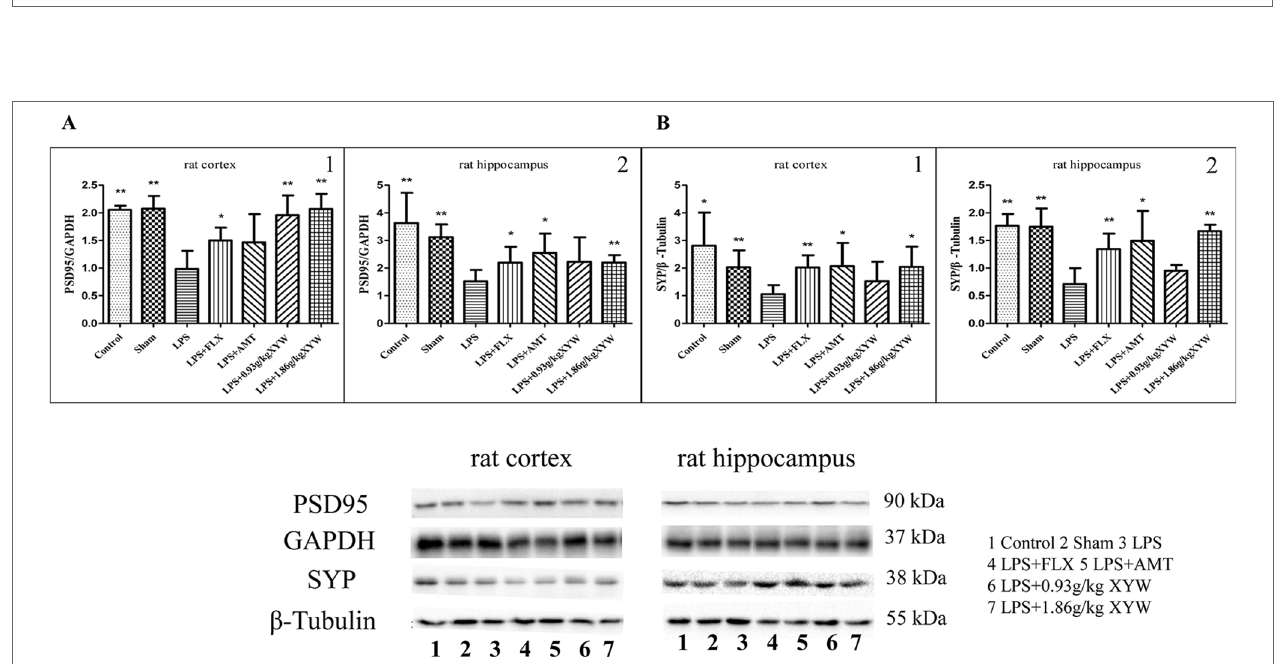
FIgURe 5 | LPS administration acutely reduced the expression of brain-derived neurotrophic factor (BDNF)/neuronal growth factor (NGF)-Tropomyosin receptor kinase (Trk) B/TrkA- cAMP response element-binding protein (CREB) in different brain regions. (a, F) Rats, The expression levels of BDNF/NGF-TrkB/TrkA-CREB following LPS treatment were significantly lower than those in the control and sham groups (P 0.05 or P 0.01), with 2 weeks of prior XYW administration (LPS + XYW [0.93,1.86 g·kg -1 ]), exhibited significantly higher levels of BDNF and NGF in serum, and Xiaoyao Pills (1.86 g·kg -1 ) caused higher transcription levels of BDNF in the cortex, NGF and TrkA in the cortex and hippocampus and TrkB in the hippocampus. Xiaoyao Pills (0.93 g·kg -1 ) treatment resulted in a higher transcription level of BDNF in the hippocampus, NGF, TrkB and CREB in the cortex and hippocampus, and TrkA in the cortex. Xiaoyao Pills (1.86 g·kg -1 ) pre-treatment could add the translation levels of BDNF, TrkB, p-CREB, CREB and increased the ratio of p-CREB/CREB in the cortex and hippocampus. The Xiaoyao Pills (0.93 g·kg -1 ) group had a higher level of translation of BDNF in the hippocampus, TrkB in the cortex, p-CREB, CREB in the cortex and hippocampus, and a higher p-CREB/ CREB ratio in the cortex and hippocampus (n≥5, P 0.05 or P 0.01) (A1, A3, A5, B1, B3, C1, D1-2, E1-2, F4: t-test, A2, B2, C2, C4, E3-4, F2: Mann-Whitney test, A4, C3, F1, F3: one-way ANOVA). BDNF: (serum:390.23 ± 98.45 vs 516.18 ± 56.72 (control) vs 646.87 ± 168.63 (sham) vs 587.51 ± 150.23 (0.93 g/kg) vs 605.59 ± 168.54 (1.86 g/kg), N = 8, cortex (PCR): 0.56 ± 0.16 vs 1.04 ± 0.31 (control) vs 1.27 ± 0.23 (sham) vs 0.69 ± 0.23 (0.93 g/kg) vs 1.15 ± 0.58 (1.86 g/kg), N = 6, hippocampus (PCR):0.68 ± 0.07 vs 1.08 ± 0.47 (control) vs 1.11 ± 0.36 (sham) vs 0.90 ± 0.12 (0.93 g/kg) vs 0.93 ± 0.25 (1.86 g/kg), N = 6 vs 5 vs 5 vs 5 vs 6, cortex (Western blot):0.65 ± 0.24 vs 1.61 ± 0.58 (control) vs 2.01 ± 0.97 (sham) vs 0.80 ± 0.08 (0.93 g/kg) vs 1.32 ± 0.52 (1.86 g/kg), N = 6 vs 6 vs 6 vs 5 vs 6, hippocampus (Western blot): 0.74 ± 0.25 vs 2.57 ± 0.29 (control) vs 2.35 ± 0.47 (sham) vs 1.35 ± 0.53 (0.93 g/kg) vs 1.91 ± 0.36 (1.86 g/kg), N = 6). NGF: [serum:95.09 ± 6.37 vs 124.38 ± 3.12 (control) vs 126.26 ± 7.85 (sham) vs 137.44 ± 22.72 (0.93 g/kg) vs 117.26 ± 17.36 (1.86 g/kg), N = 8 vs 7 vs 7 vs 7 vs 8, cortex:0.55 ± 0.72 vs 1.06 ± 0.44 (control) vs 0.92 ± 0.33 (sham) vs 0.87 ± 0.10 (0.93 g/kg) vs 1.11 ± 0.51 (1.86 g/kg), N = 6, hippocampus:0.71 ± 0.10 vs 1.02 ± 0.27 (control) vs 1.09 ± 0.10 (sham) vs 1.07 ± 0.29 (0.93 g/kg) vs 1.06 ± 0.28 (1.86 g/kg), N = 6 vs 5 vs 5 vs 5 vs 6]. TrkB: (PCR: cortex: 0.48 ± 0.08 vs 1.03 ± 0.25 (control) vs 0.87 ± 0.20 (sham) vs 0.79 ± 0.14 (0.93 g/kg) vs 1.26 ± 0.83 (1.86 g/kg), N = 6, hippocampus: 0.51 ± 0.11 vs 1.01 ± 0.19 (control) vs 1.20 ± 0.37 (sham) vs 1.22 ± 0.17 (0.93 g/kg) vs 0.93 ± 0.29 (1.86 g/kg), N = 5 vs 5 vs 5 vs5 vs 6). [Western blot: cortex: 1.27 ± 0.37 vs 2.87 ± 1.23 (control) vs 2.34 ± 0.11 (sham) vs 2.87 ± 1.04 (0.93 g/kg) vs 2.17 ± 0.48 (1.86 g/kg), N = 6 vs 6 vs 4 vs 6 vs 5, hippocampus: 1.98 ± 1.05 vs 5.88 ± 2.28 (control) vs 6.39 ± 1.10 (sham) vs 3.17 ± 2.07 (0.93 g/kg) vs 6.78 ± 1.36 (1.86 g/kg), N = 6]. TrkA: [PCR: cortex: 0.56 ± 0.07 vs 1.05 ± 0.33 (control) vs 1.17 ± 0.47 (sham) vs 0.89 ± 0.11 (0.93 g/kg) vs 1.46 ± 0.78 (1.86 g/kg), N = 6, hippocampus: 0.57 ± 0.10 vs 0.90 ± 0.38 (control) vs 0.99 ± 0.23 (sham) vs 0.78 ± 0.21 (0.93 g/kg) vs 0.99 ± 0.37 (1.86 g/kg), N = 6 vs 5 vs 5 vs 5 vs 6]. CREB: [PCR: cortex: 0.70 ± 0.15 vs 1.04 ± 0.33 (control) vs 0.95 ± 0.22 (sham) vs 0.95 ± 0.15 (0.93 g/kg) vs 1.38 ± 0.65 (1.86 g/kg), N = 6, hippocampus: 0.65 ± 0.17 vs 1.00 ± 0.15 (control) vs 1.24 ± 0.50 (sham) vs 0.86 ± 0.12 (0.93 g/kg) vs 0.79 ± 0.18 (1.86 g/kg), N = 6 vs 5 vs 5 vs 5 vs 6]. [Western blot: cortex: 1.05 ± 0.03 vs 2.47 ± 0.09 (control) vs 2.19 ± 0.43 (sham) vs 1.93 ± 0.22 (0.93 g/kg) vs 2.00 ± 0.24 (1.86 g/kg), N = 5 vs 4 vs 6 vs 6 vs 6, hippocampus: 1.12 ± 0.32 vs 3.07 ± 0.37 (control) vs 3.06 ± 0.78 (sham) vs 2.17 ± 0.35 (0.93 g/kg) vs 2.62 ± 0.84 (1.86 g/kg), N = 6]. p-CREB: [Western blot: cortex: 0.37 ± 0.11 vs 1.33 ± 0.16 (control) vs 1.09 ± 0.34 (sham) vs 0.98 ± 0.10 (0.93 g/kg) vs 1.01 ± 0.16 (1.86 g/kg), N = 6, hippocampus: 0.43 ± 0.07 vs 1.74 ± 0.37 (control) vs 1.73 ± 0.23 (sham) vs 1.24 ± 0.21 (0.93 g/kg) vs 1.48 ± 0.29 (1.86 g/kg), N = 6]. p-CREB/CREB: [Western blot: cortex: 0.34 ± 0.11 vs 0.52 ± 0.11 (control) vs 0.50 ± 0.14 (sham) vs 0.51 ± 0.03 (0.93 g/kg) vs 0.50 ± 0.07 (1.86 g/kg), N = 5 vs 6 vs 6 vs 6 vs 6, hippocampus: 0.41 ± 0.11 vs 0.57 ± 0.13 (control) vs 0.59 ± 0.15 (sham) vs 0.58 ± 0.11 (0.93 g/kg) vs 0.61 ± 0.16 (1.86 g/kg), N = 6].